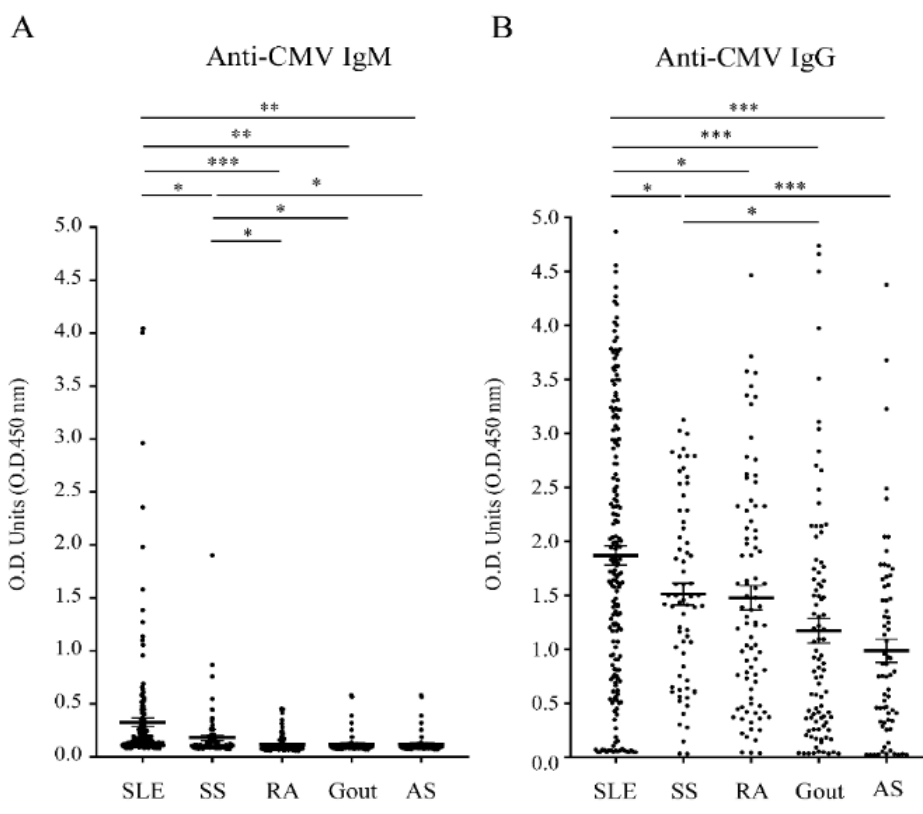
Figure 1. ELISA analysis of the antibody response to CMV using sera of patients with SLE ( n = 193), SS ( n = 70), RA ( n = 84), gout ( n = 92), and AS ( n = 68). ( A ) Anti-CMV IgM activity. ( B ) Anti-CMV IgG activity. * p ≤ 0.05; ** p ≤ 0.01; *** p ≤ 0.001.